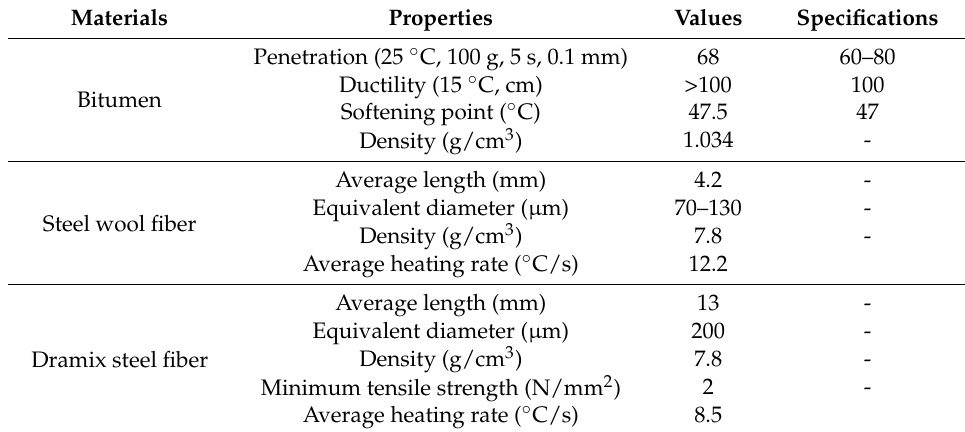
Figure 1. Morphology of steel wool fibers ( a ) and Dramix steel fibers ( b ). Table 1. The properties of bitumen and steel fibers.